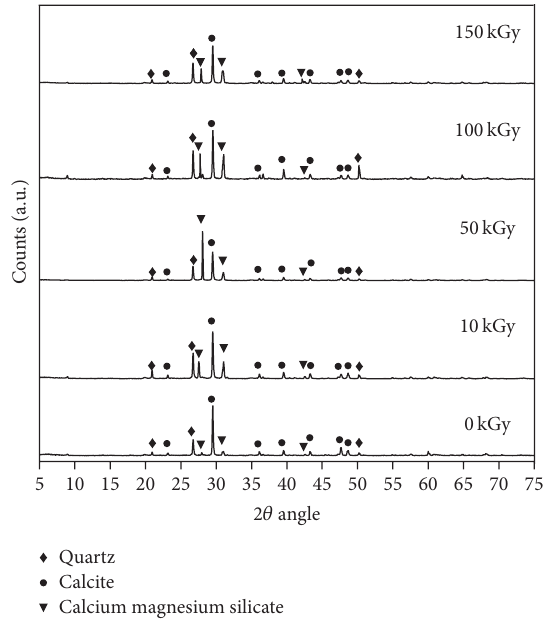
Figure 1: X-ray diffraction spectrum of nonirradiated and irradi- ated minerals.